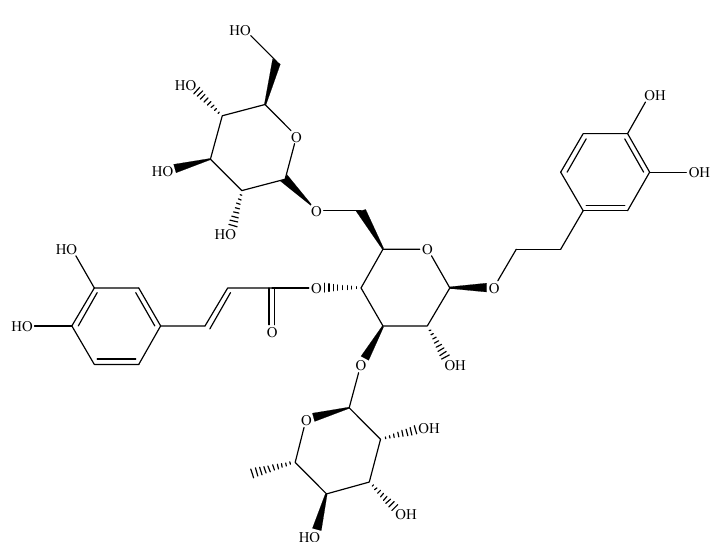
Figure 2. Chemical structure of ECH.